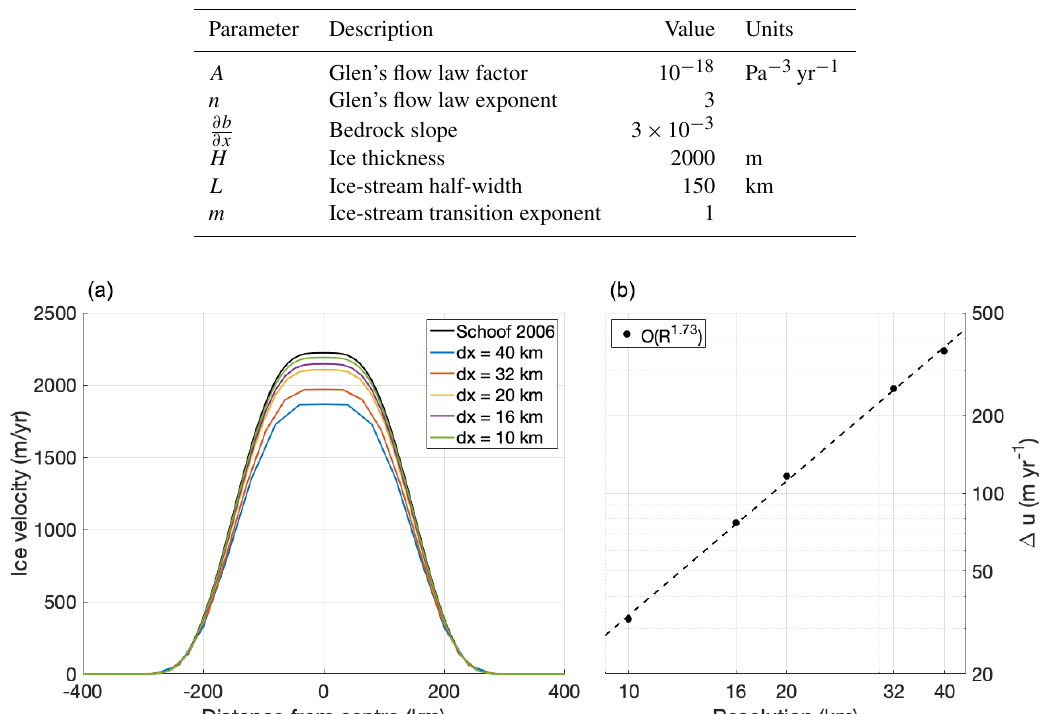
Table 4. Parameters for the SSA ice-stream experiment.